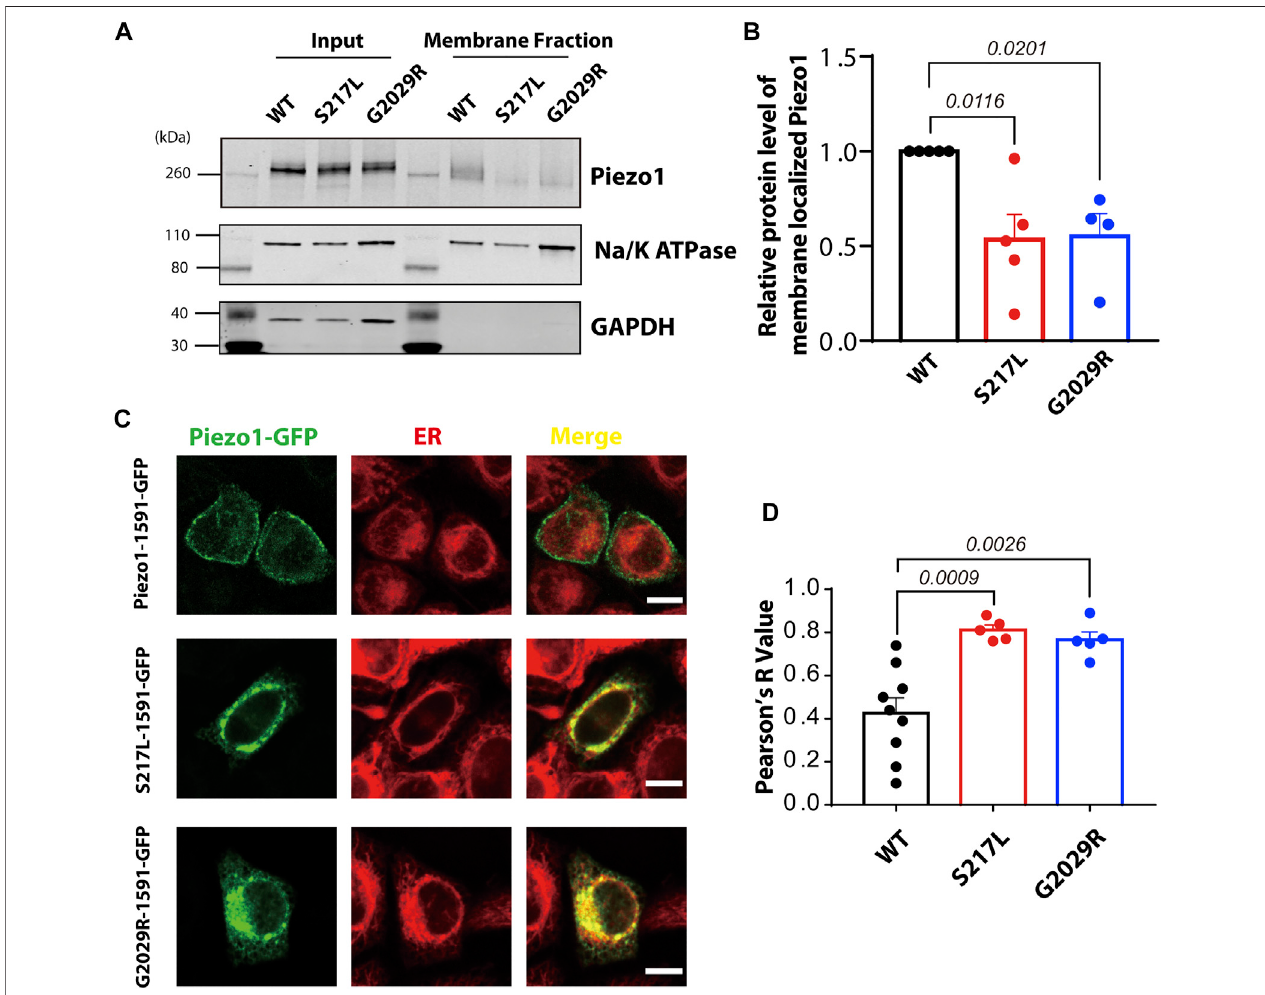
FIGURE 3 | S217L and G2029R are traf fi cking-de fi cient mutants. (A) Western blot showing the membrane localized fraction of WT and mutant Piezo1 proteins Piezo1 from Piezo1 − / − HEK293T cells using a standard biotinylation assay. The membrane fraction of the eluted lysate is visualised using the ubiquitous membrane protein Na + /K + ATPase and the cytosolic protein GAPDHisshown asacomparison forwhole protein lysate (Input) and bead elution(Membrane Fraction). (B) Summary data of panel (A) . One way ANOVA with Dunnett ’ s multiple comparison test was used for statistical analysis. (C) HeLa cells overexpressing WT or mutant Piezo1 with GFP tag were stained with ER tracker and analysed using confocal microscopy. Notice that the WT Piezo1 is localized to the plasma membrane while the mutant Piezo1 co-localizes almost exclusively with the ER tracker. Scale bar, 10 µm. (D) Summary data showing the overlap of GFP (Piezo1) and the ER signal indicated by Pearson ’ s R value. One way ANOVA with Dunnett ’ s multiple comparison test was used for statistical analysis.